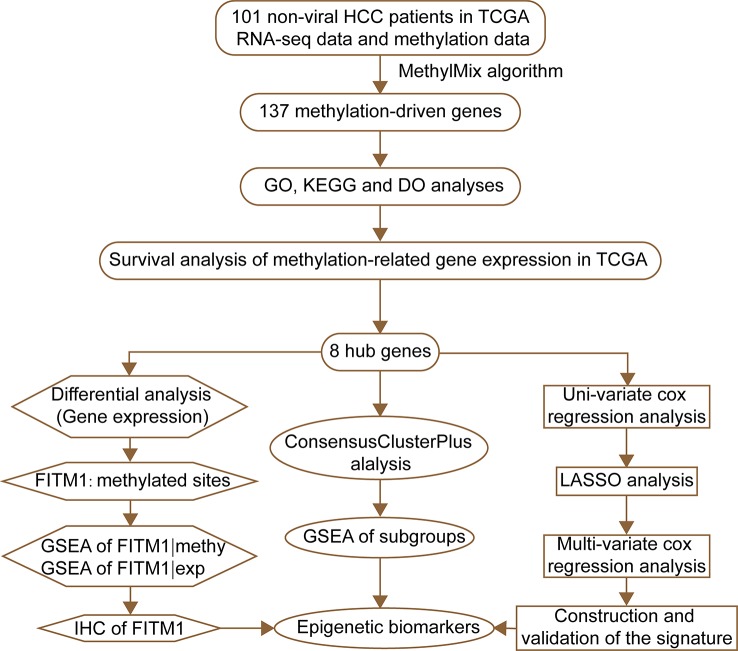
The flowchart of this study.